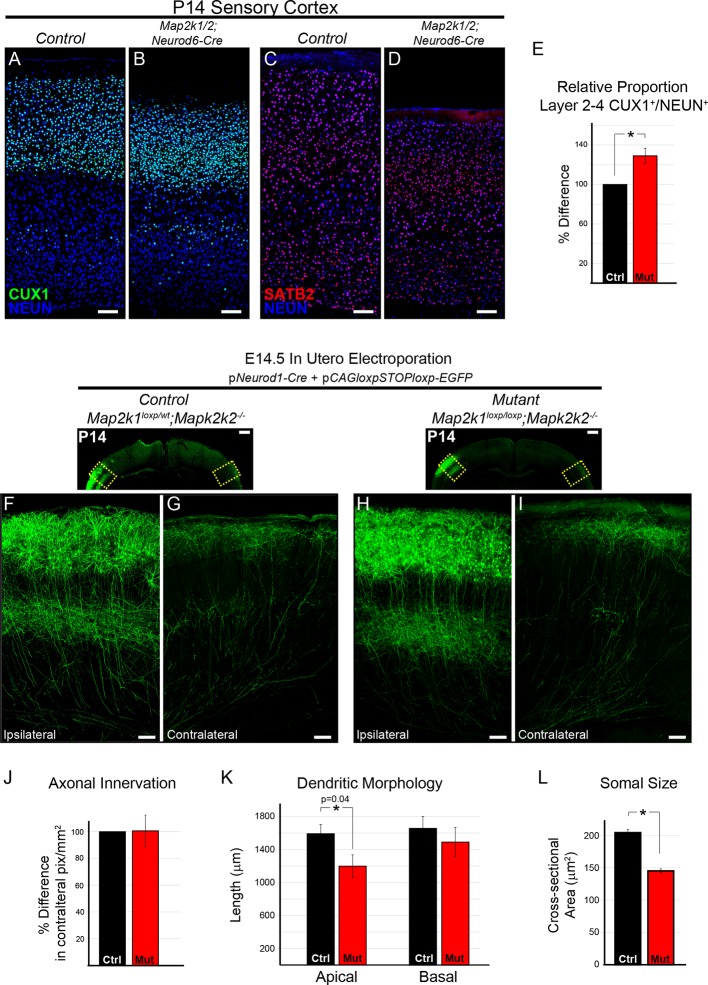
The differentiation and morphology of callosal projecting neurons in layer 2/3 does not require ERK/MAPK signaling during development.(A–E) Analysis of intracortical neuron markers, CUX1 (A–B) and SATB2 (C–D), from confocal images of P14 control (A, C) and Map2k1/2;Neurod6-Cre (B, D) sensory cortices did not reveal significant differences in overall expression. (E) Quantitation of the proportion of CUX1 labeled neurons in layer 2–4 as a percentage of NEUN labeled neurons in a radial unit was not decreased in mutant mice when compared to controls (n=3, mean ± SEM, *p=0.033, scale bar = 100 µm). (F–L) Cell autonomous deletion of Map2k1/2 and labeling of a subset of layer 2/3 cortical neurons through unilateral in utero electroporation (IUEP) of pNeurod1-Cre and ploxp-STOP-loxpEGFP into the E14.5 ventricular zone. Following IUEP, coronal forebrain sections from electroporated P14 Map2k1wt/loxp;Map2k2-/-control (F–G) and Map2k1loxp/loxp;Map2k2-/- mutant (H–I) mice were immunostained for EGFP. Representative two-dimensional projections of confocal Z-stack images of EGFP-labeled layer 2/3 neuron bodies and dendrites in the electroporated hemisphere (F, H) and associated callosally projecting axons in the contralateral hemisphere (G, I) are shown (scale bar=50 µm). (J) The extent of axonal innervation was assessed by quantifying the number of labeled pixels within contralateral radial units. A significant difference in axonal innervation was not detected following loss of ERK/MAPK signaling (n=3, mean ± SEM, p=0.97). K. High resolution confocal Z-stacks of EGFP expressing layer 2/3 neurons were collected from control and mutant sections. Reconstruction and analysis of randomly selected layer 2/3 neurons show that the length of apical dendritic arbors was modestly reduced in Map2k1/2 deleted layer 2/3 neurons (K) (n=10 control and 11 mutant neurons, mean ± SEM, p=0.04). No significant effect on basal dendrite length was detected in mutant neurons (mean ± SEM, p=0.625). (L) Somal size assessment revealed a substantial decrease in the cross sectional size of EGFP labeled layer 2/3 neuron cell bodies following IUEP mediated Map2k1/2 deletion (n>100 neurons per condition, mean ± SEM, *p<0.001).